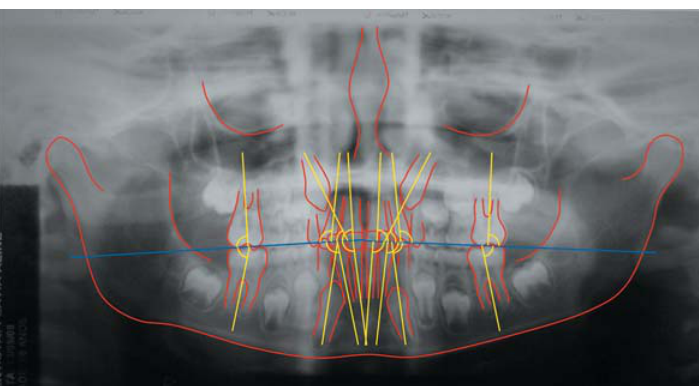
Figure 1- Panoramic radiograph showing the anatomic structures, the dental long axes and the angles measured relative to the reference line measured on the external